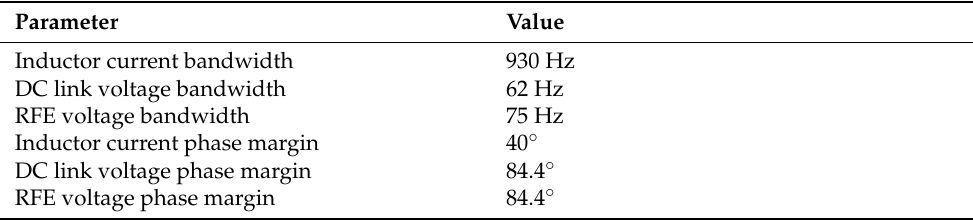
Table 5. Controller-tuning